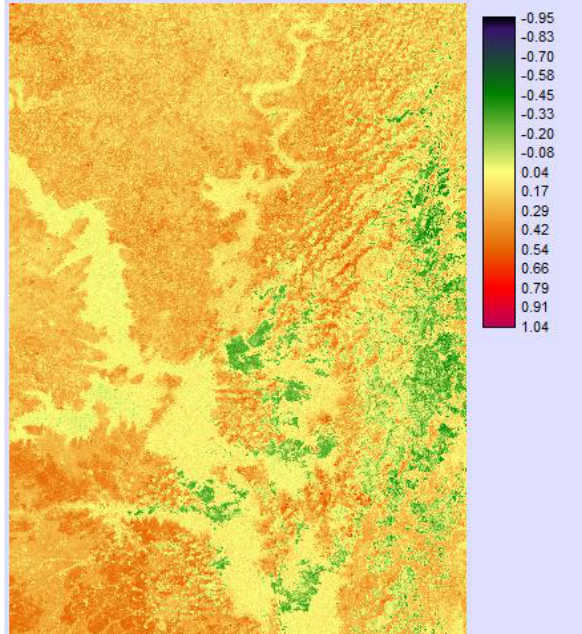
Fig.5: A dNBR image indicating change in Vegetative cover